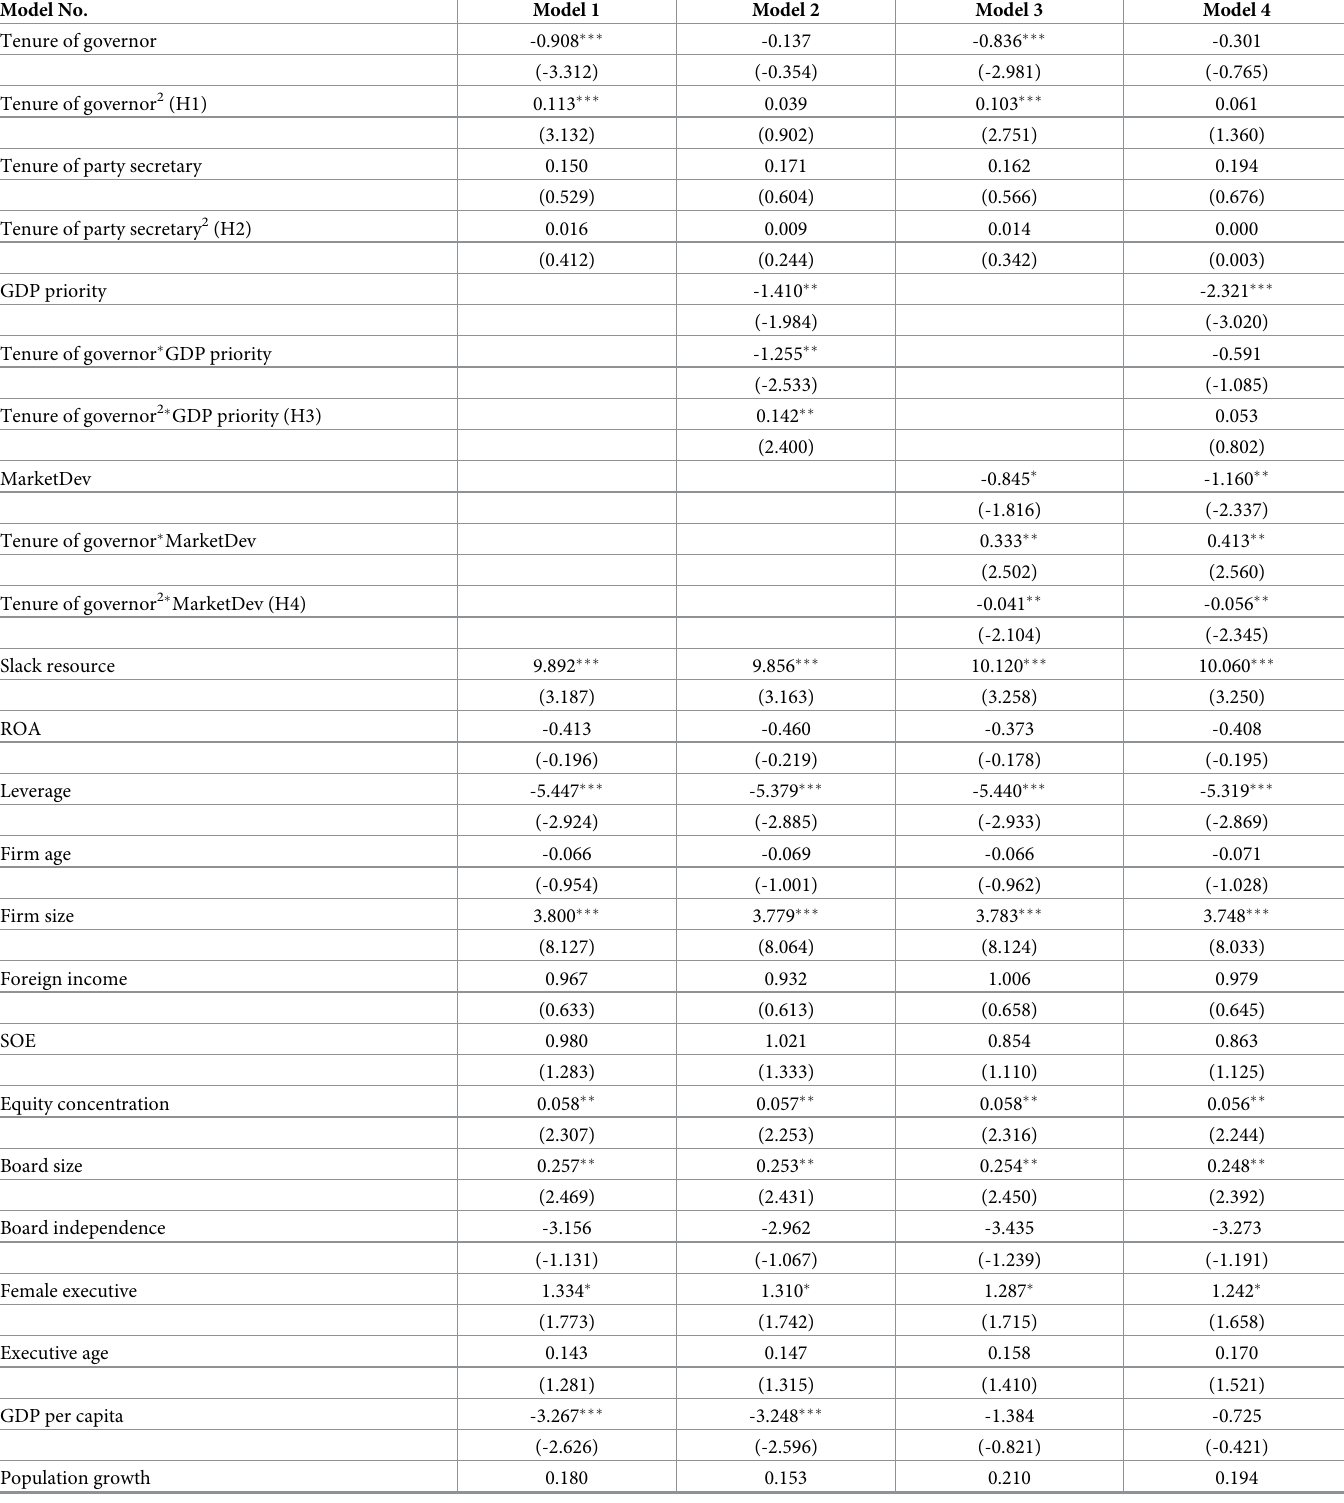
Table 6. Robustness checks excluding the samples of municipalities. Model